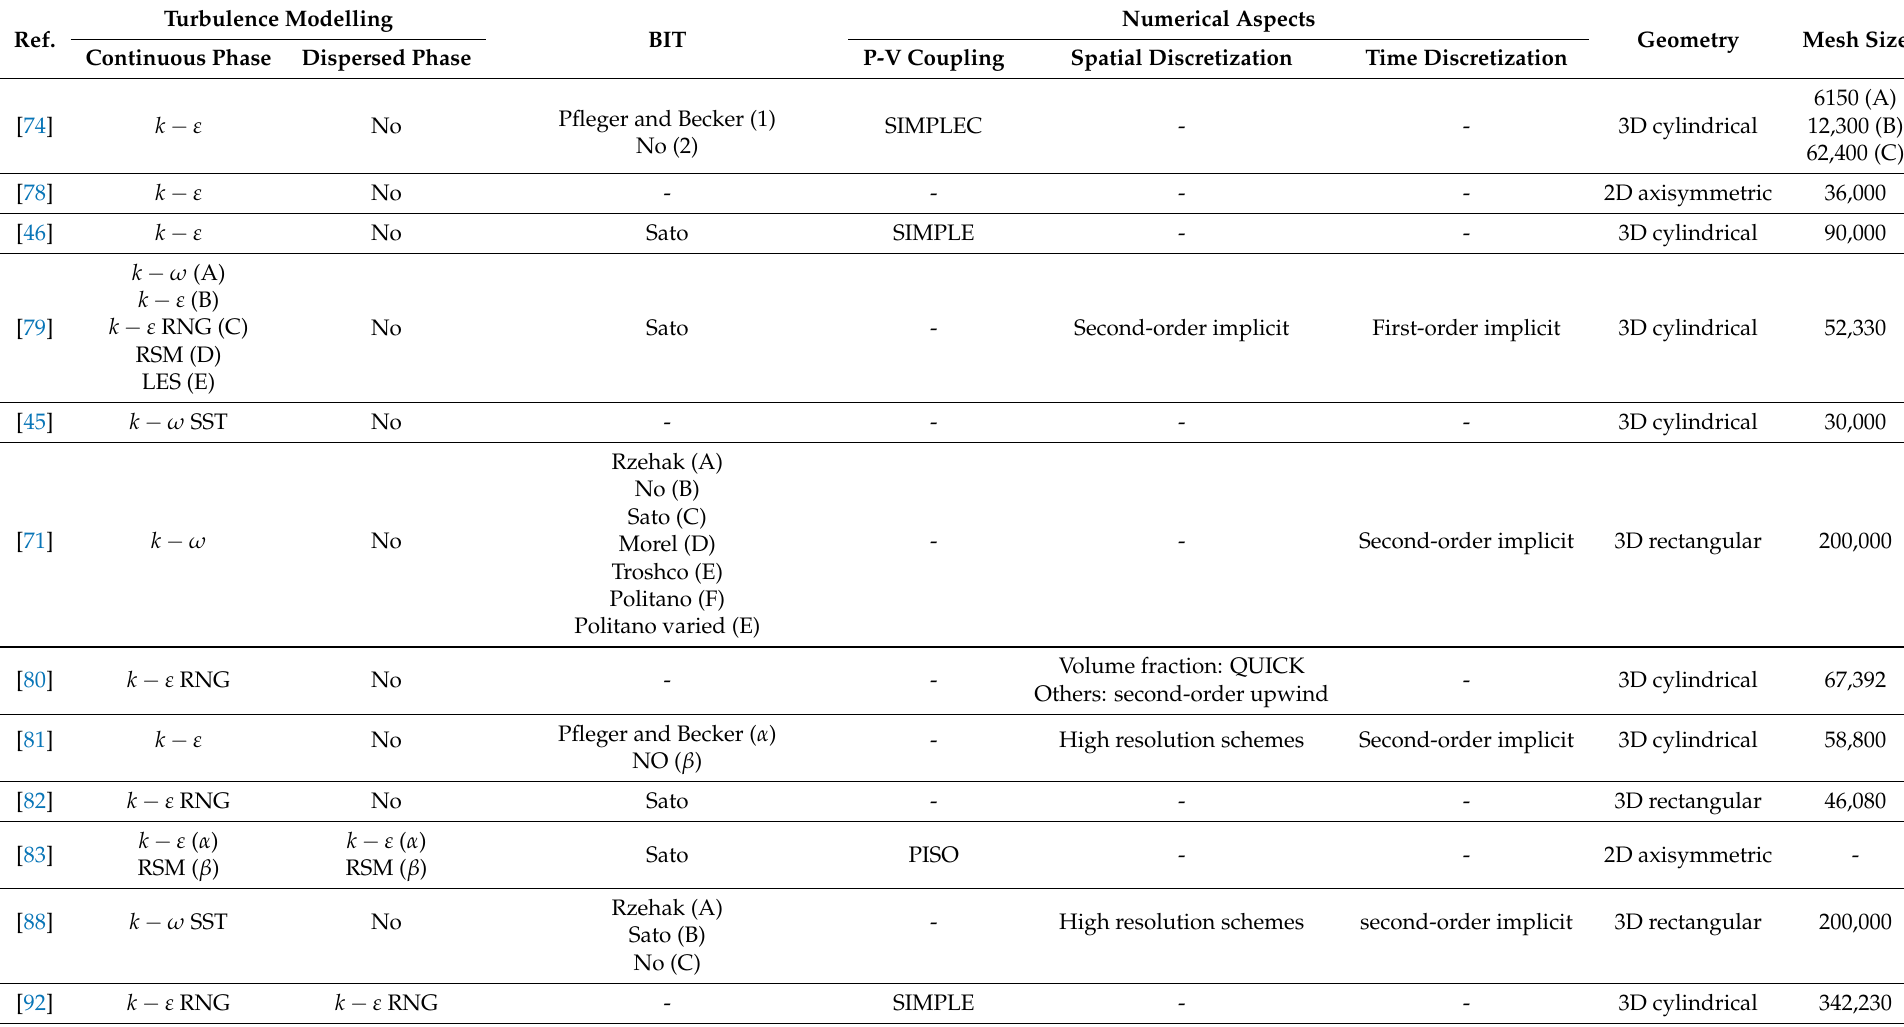
Table 7. Literature survey: numerical